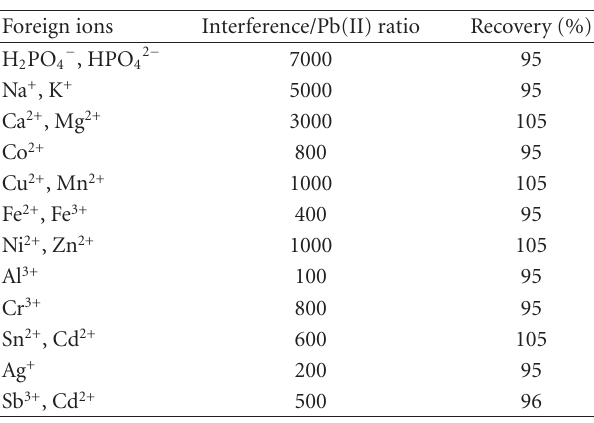
Table 2: Tolerance limit of the foreign ions. Foreign ions